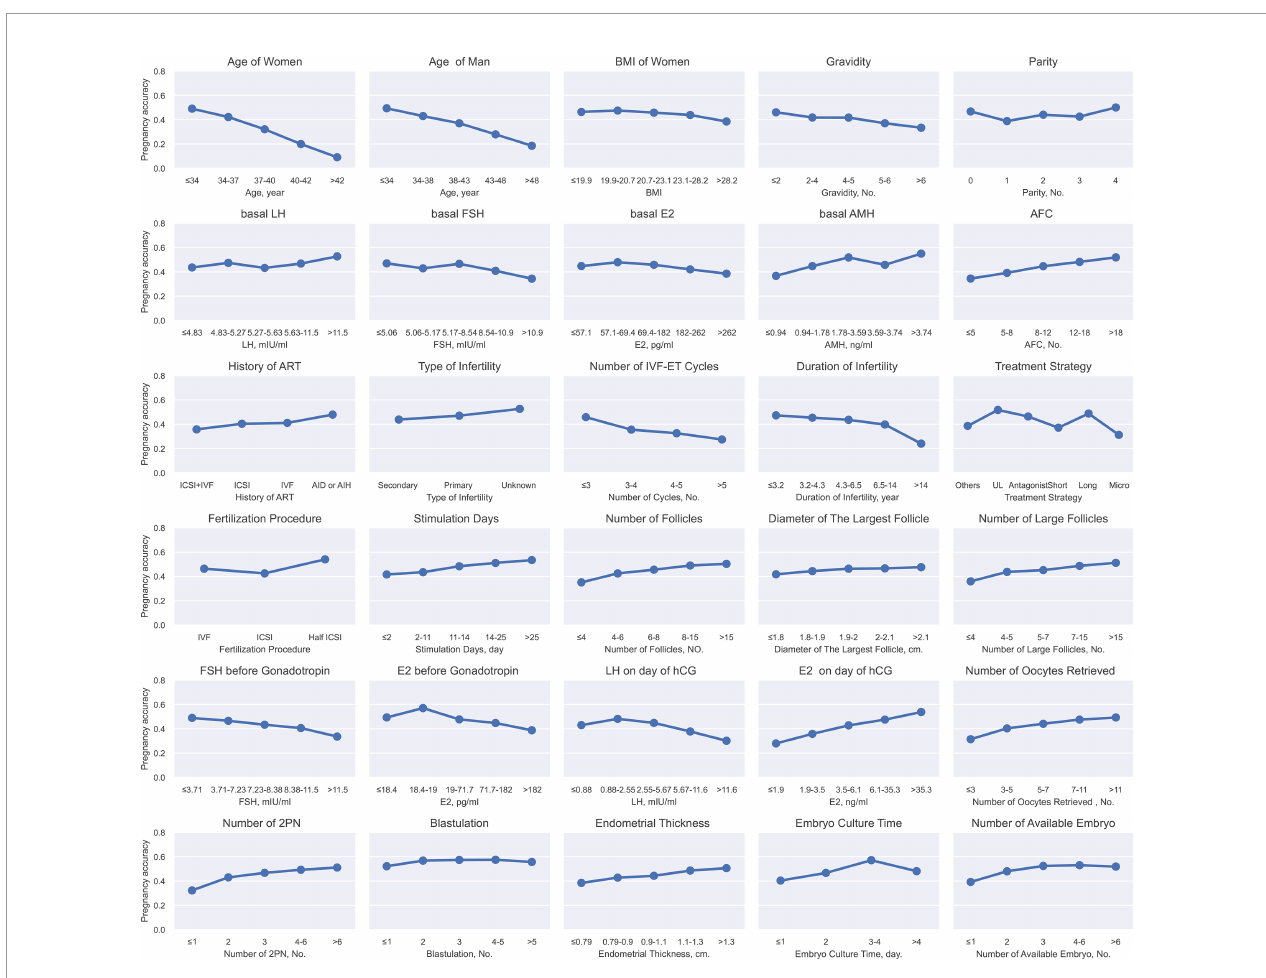
FIGURE 2 | Continuous variables after binning and categorical variables for GBDT. This fi gure described the continuous variables after binning and categorical variables for GBDT. The X-axis represented the different grades of continues variable after binning or categorical variables. The Y-axis represented pregnancy rate. BMI (body mass index), LH (luteinizing hormone), FSH (follicle-stimulating hormone), E2 (estradiol), AMH (anti-Mullerian hormone), AFC (Antral follicle count), IVF ( in vitro fertilization), ICSI (intracytoplasmic sperm injection), AI (arti fi cial insemination), UL (ultra-long), Micro (microstimulation), hCG (human